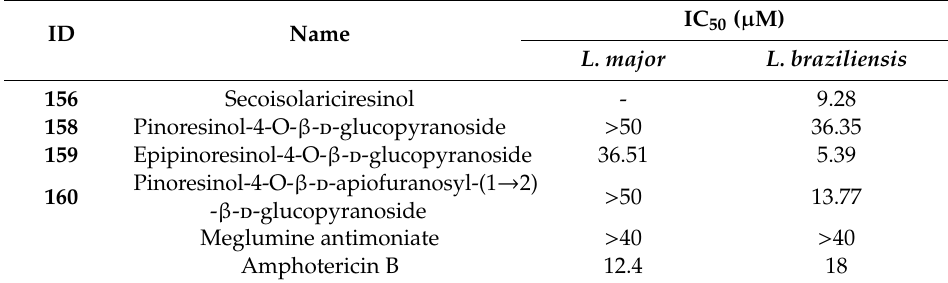
Table 12. Antileishmanial activity of lignans against L. major and L. braziliensis